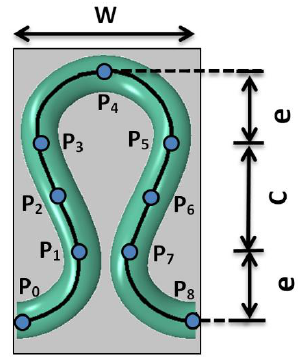
Figure 2. Geometry of a plain weft knitted loop.